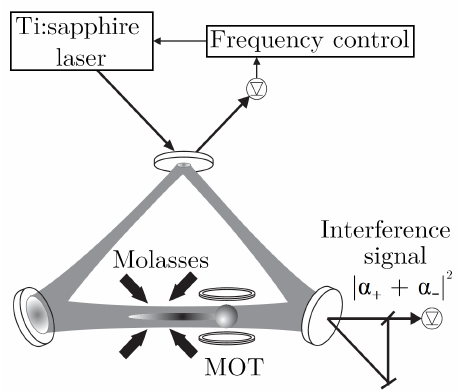
Figure 10. The optical layout of the CARL experiment employed in the review [19] is depicted here. Captured cold atoms from a magneto-optical trap are loaded in a dipole potential generated by a ring cavity and, afterwards, they are exposed to an optical molasses. The phase shifts of the standing wave are monitored using the frequency beat of the cavity modes, which propagate in opposite directions. Reprinted with permission from ref. [19]. Copyright 2005 Americal Institute of